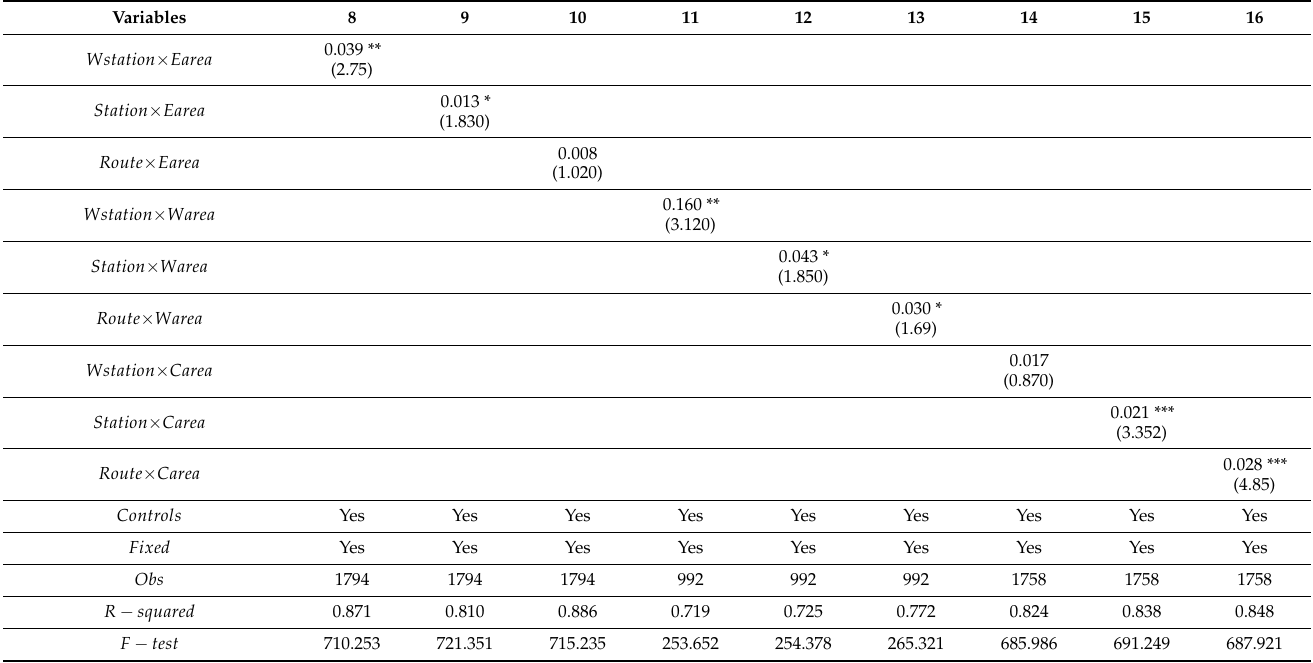
Table 4. The test for regional